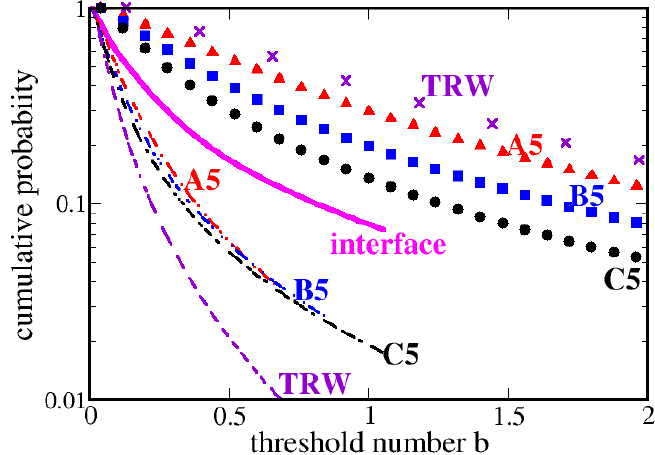
Figure 3. Cumulative probability that the normalized absolute value of local curvature of reaction zone is larger than a positive threshold number b. Lines and symbols show results obtained by normalizing the curvature using the Kolmogorov length scale η and the laminar-wave thickness δ F , respectively. All results were obtained in cases characterized by the same u’ ⁄ S L = 10, but different L 11 ⁄ δ F = 2.1 (cases A5 and TRW), L 11 ⁄ δ F = 3.7 (case B5), or L 11 ⁄ δ F = 6.7 (case C5). In case TRW, the laminar reaction-wave thickness δ F is larger by a factor of four when compared to a reference value used in all other cases associated with Equations (4) and (5). Magenta solid line shows DNS data obtained by solving the level set Equation (3).